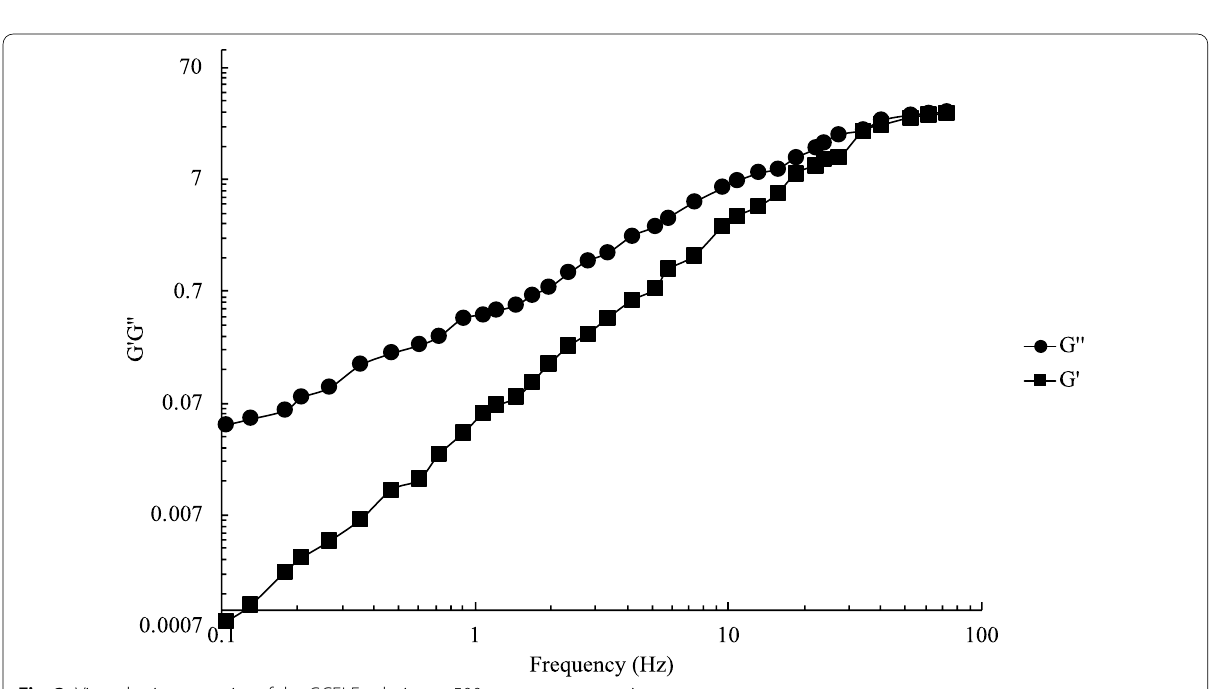
Fig. 3 Viscoelastic properties of the GCELE solution at 500 wppm